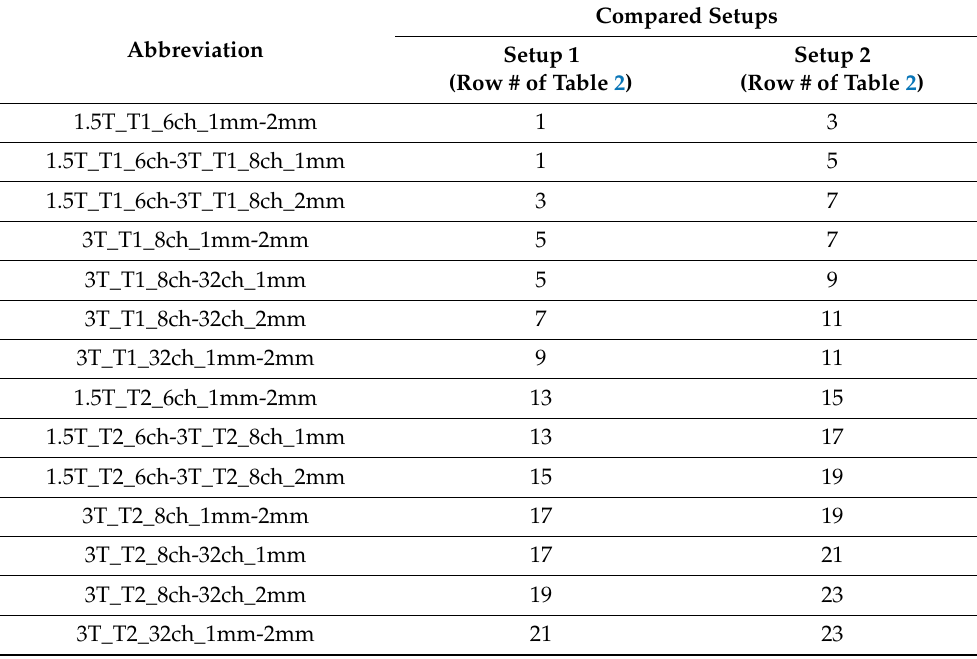
Table 3. List of abbreviations for calculating the RPD at T1 and T2 contrast. The first column contains the abbreviations, and the second and third columns show the serial number of the acquisition setup defined in Table